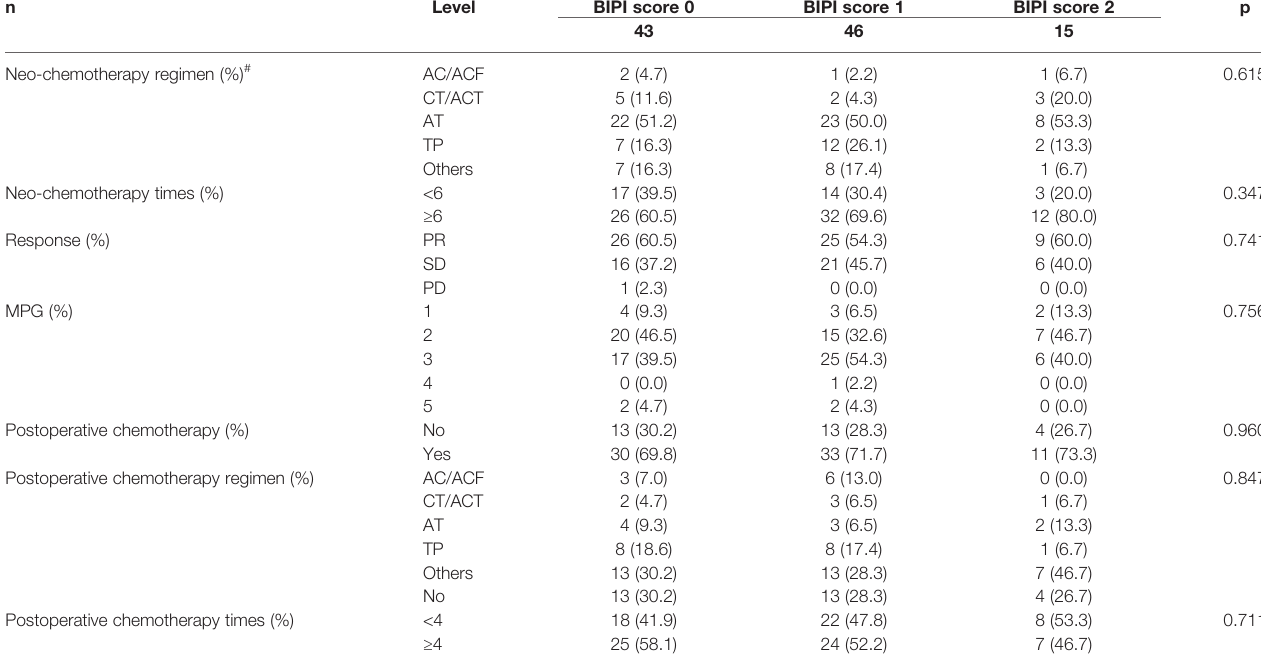
TABLE 3 | Patients ’ chemotherapy for all patients in accordance with breast immune prognostic index (BIPI).